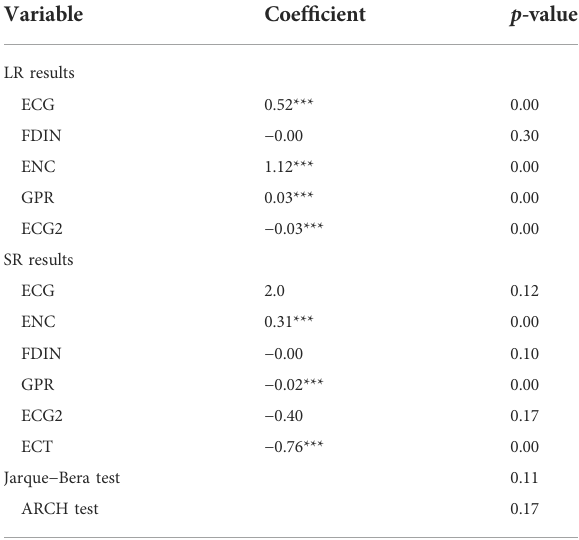
TABLE 6 Findings from PMG − ARDL for developing countries.